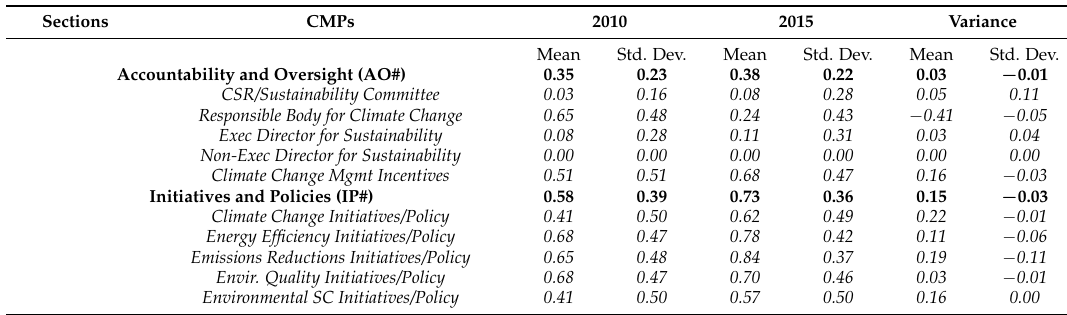
Table 2. Summary of descriptive